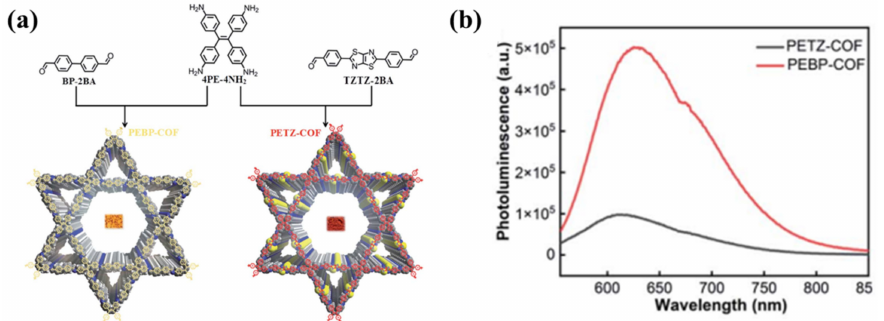
Figure 3. ( a ) Synthesis of the D-A COFs in this work. ( b ) Steady-state PL spectra of PETZ–COF and PEBP-COF excited by using a 540 nm laser. Reproduced with permission from Ref. [42]. Copyright: Royal Society of Chemistry,